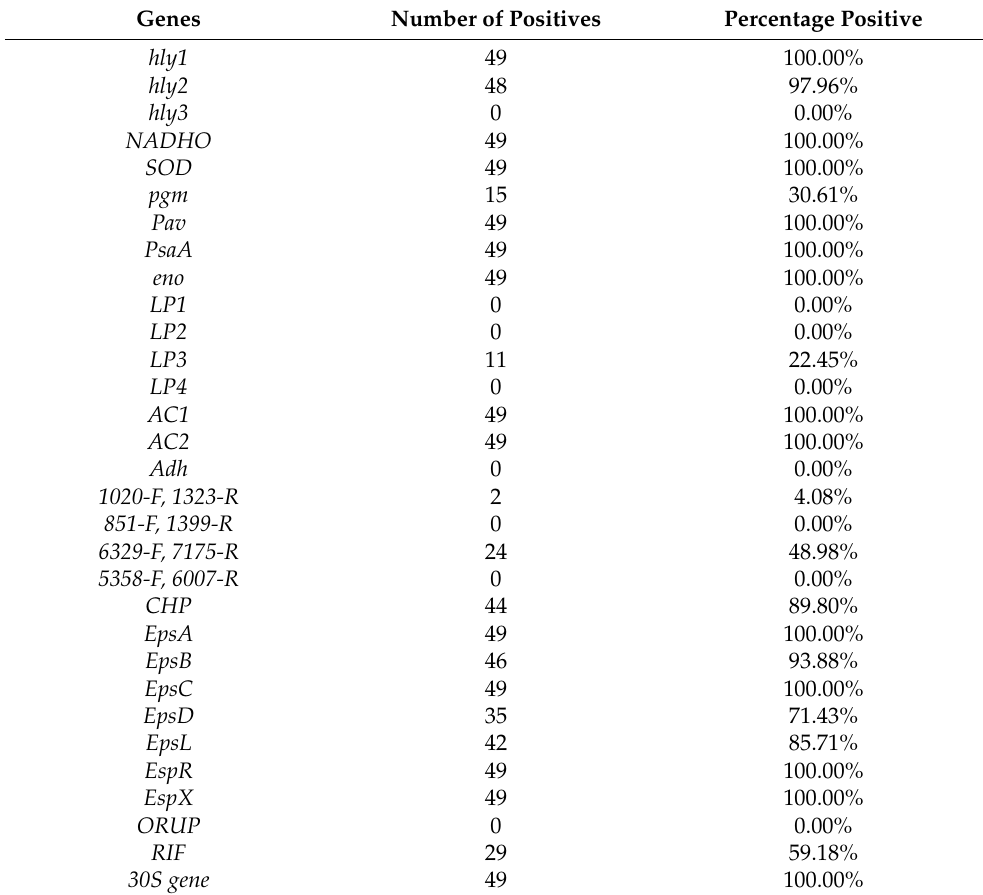
Figure 5. Identification of different virulence genes amongst L. garvieae isolates. M: 100 bp DNA ladder. Lanes 1 − 23: hly1, hly 2, NADHO, SOD, pgm, Pav, PsaA, eno, LP3, AC1, AC2, CGC (1020- rRNA gene. Table 5. Putative Virulence Gene Detection results of 49 L. garvieae